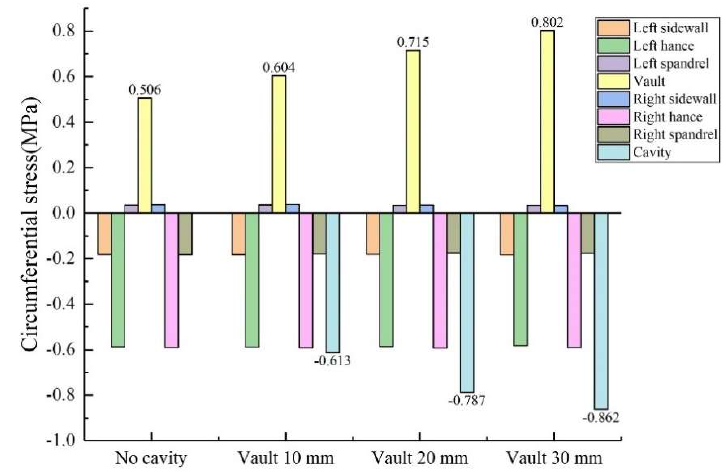
Figure 12. Variation of circumferential stress with vault void depth.